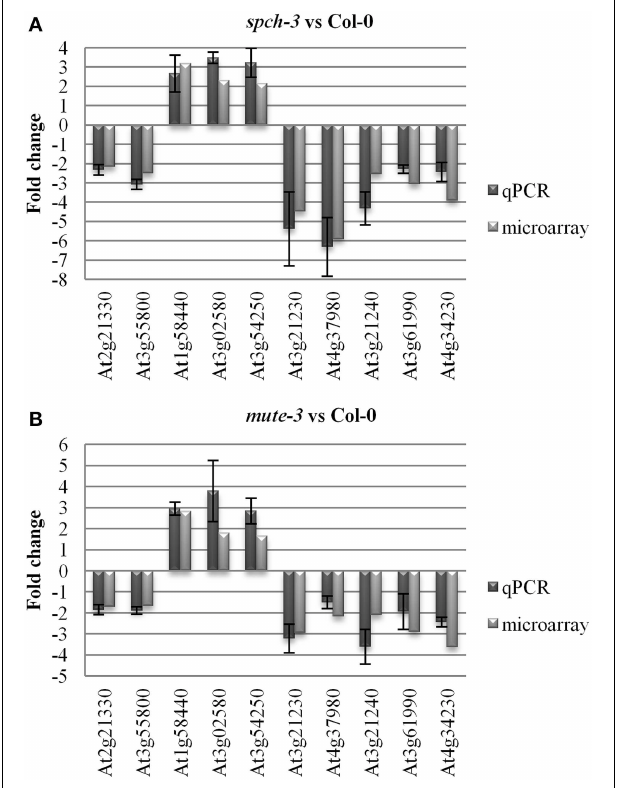
FIGURE 3 | Quantitative PCR for microarray validation. Arrays were validated by quantitative RT-PCR for 10 genes selected from the list in Table S3. UBIQUITIN10 and ACTIN2 served as reference genes. The fold change of the qPCR was determined by the efficiency method (E CtT(C) − CtT(S) T × E CtR(S) − CtR(C) R ). The results of qPCR for spch-3 (A) and mute-3 (B) respect to Col-0 were averaged from three independent experiments, with the error bar indicating the standard error of the